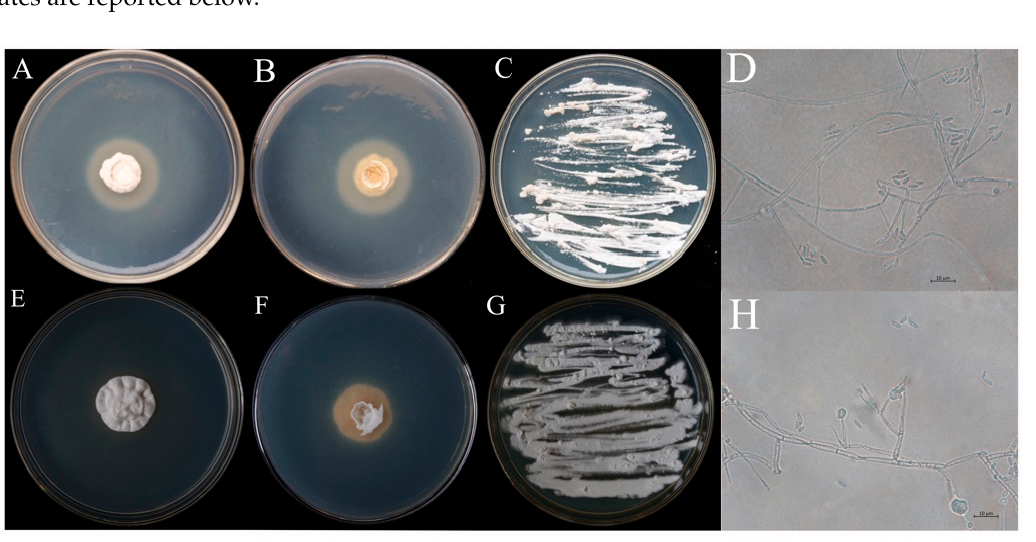
Figure 1. Colony morphology and conidia morphology of two Akanthomyces attenuatus isolates (SCAUDCL-38 and SCAUDCL-56). ( A – C ) Colony morphology of 10-day-old SCAUDCL-38; ( D ) conidia of isolate SCAUDCL-38; ( E – G ) colony morphology of 10-day-old SCAUDCL-56; ( H ) conidia of isolate SCAUDCL-56.